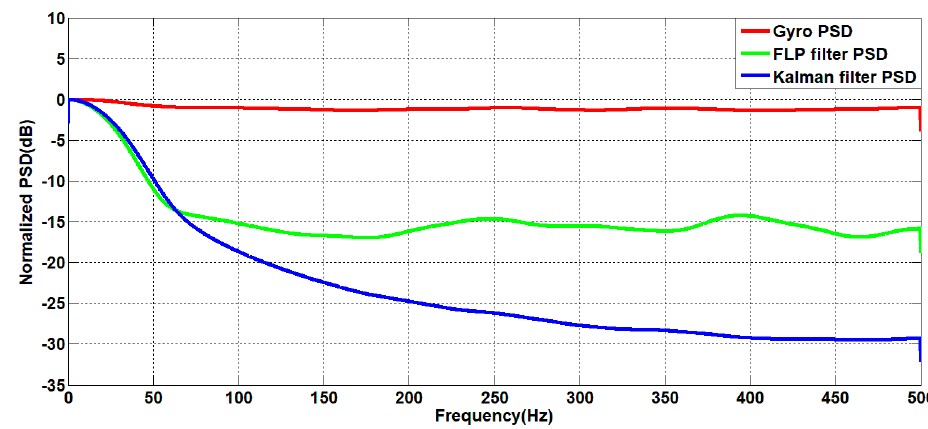
Figure 10. Power spectrum of the angular velocity signal before and after filtering.